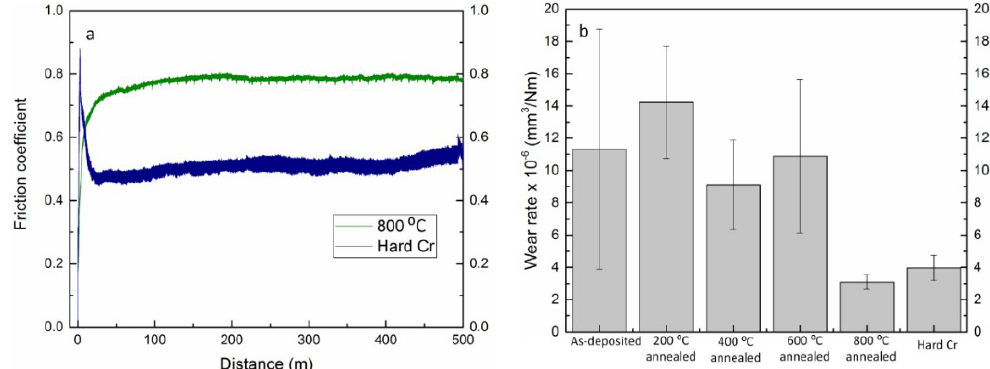
Figure 8. Coefficient of friction evolution for the Fe-24W coating annealed at 800 °C and hard chromium coatings ( a ), and wear rate of the Fe-24W and hard chromium coatings ( b ).